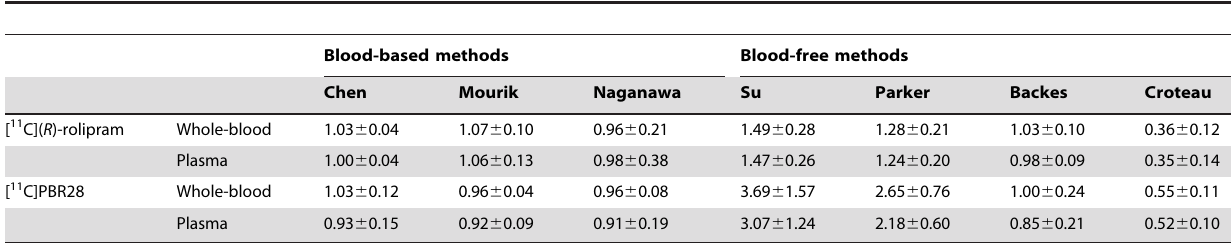
Table 1. AUC ratio (mean 6 SD) calculated for each method and for both whole-blood and plasma curves for each tracer.